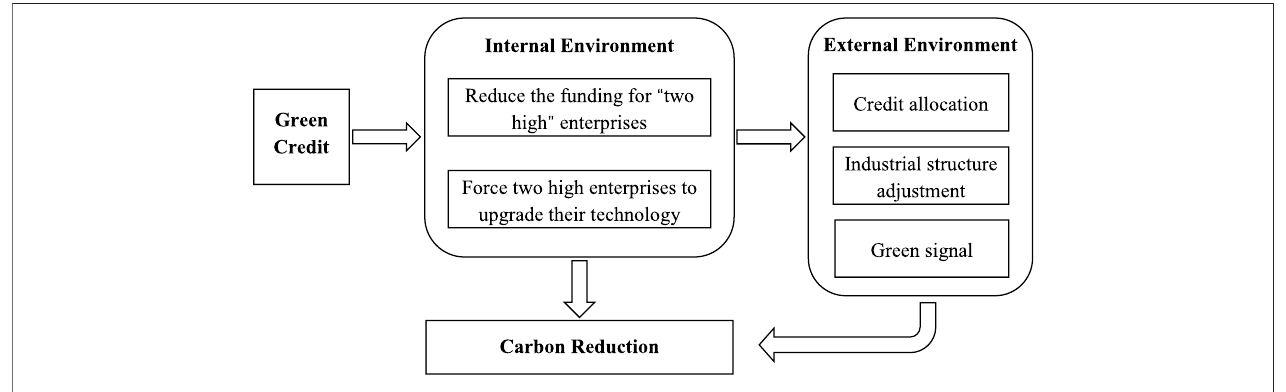
FIGURE 1 | Green credit ’ s impact mechanism on carbon reduction via disruptive